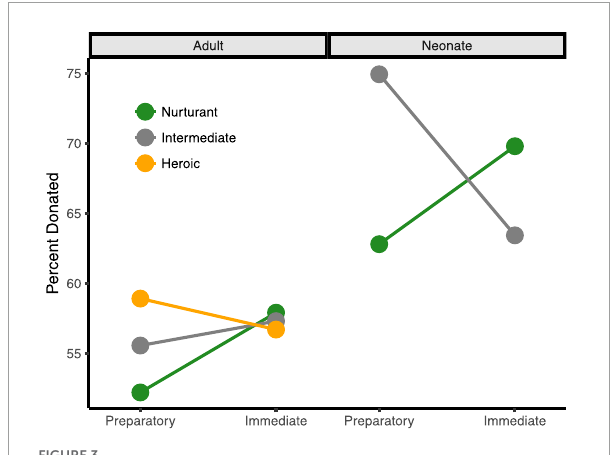
FIGURE3 The three-way behavioral donation effect. Estimated mean percent of tokens donated by condition (percentages are used since token earnings varied by trial). Charities that assisted adults are on the left half while those that assisted neonates are on the right. For visualization only, charities < 1.5 SD s from the neutral midpoint were classified as Nurturant (green), charities > 1.5 SD s from the midpoint were classified as Heroic (orange), and charities at the midpoint were classified as Intermediate (gray). Charities assisting neonates were always rated as more nurturant and not